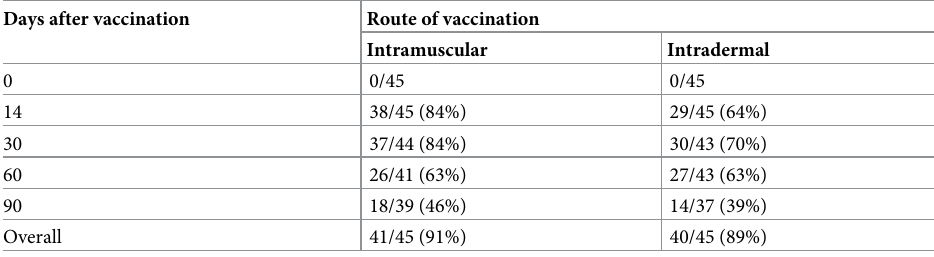
On day 0, all tested cattle had titres < 0.17 IU/mL. Based on this cut-off point, the overall response rate for the intramuscular group was 98% and for the intradermal group 96% (Table 2). Accord- ing to the p values calculated using generalised linear model, the overall proportion of the cattle with VNA titre � 0.17 IU/mL was not affected by route of vaccination (p = 0.35) or the interac- tion between vaccination route and time after vaccination (p = 0.31). However, compared to Day 0, the proportion of vaccinated cattle with a titre � 0.17 IU/mL was greater on all other sample days (p < 0.001); this was also the case for days 14 and 30 compared to day 90 (p � 0.02). Proportion of animals with an adequate VNA titre The proportion of vaccinated cattle with VNA titre � 0.24 IU/mL) is summarised in Table 3. As with the proportion of cattle with a titre � 0.17 IU/mL, according to the p values calculated using a generalised linear model, there was no effect of vaccination route or interaction between vaccination route and time on the odds of a vaccinated animal having a titre � 0.24 IU/mL (p = 0.67 and 0.38, respectively), but there was an effect of time since vaccination (p < 0.001) S1 Fig. Proportion of animals with a VNA titre above the OIE minimum for sero-positivity (0.5 IU/mL). According to the p values calculated using a generalised linear model, no effect of vaccination route on proportion of titres � 0.5 IU/mL was found (p = 0.538). However, both the interaction between vaccination route and time and time alone were significant at the 4% level (p = 0.039 and < 0.001, respectively). On both day 14 and day 30 the proportion of cattle with a VNA titre � 0.5 IU/mL was lower in the intradermally vaccinated group than in the intramuscularly vaccinated group (p < 0.001 and 0.02, respectively) (Table 4). Effect of vaccination route and time on VNA titres Time, vaccination route and their interaction were found to have an effect on VNA titres (p < 0.001) (see Fig 1). In both groups, VNA titres were higher after vaccination throughout the Table 3. Proportion of cattle in each vaccination group with VNA titre � 0.24